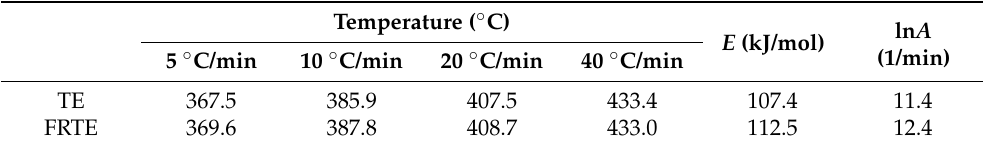
Table 2. Kinetic data for TE and FRTE degradation by the Kissinger method.